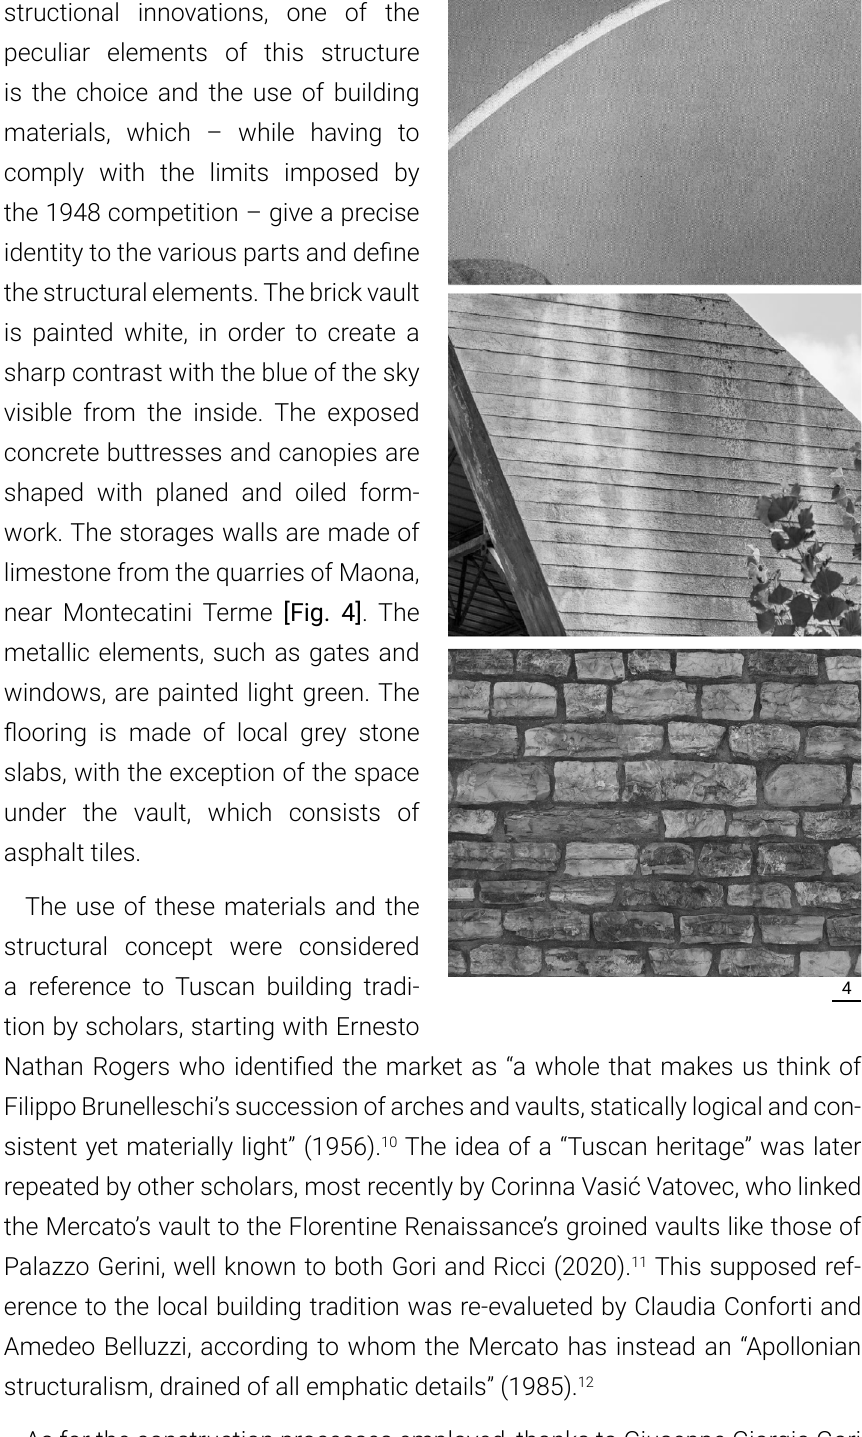
Fig. 3 Mercato dei Fiori, Pescia: plan, side façade, section (source: Casabella-continuità, no. 209,